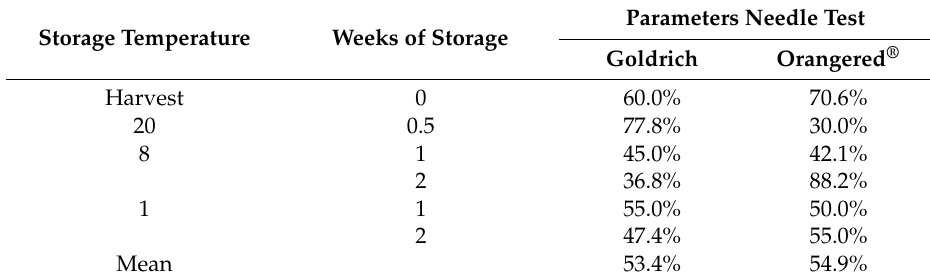
Table 4. Percentage of correctly classified ‘Goldrich’ and ‘Orangered ® ’ apricots according to storage temperature and duration obtained with DA performed on 10 parameters extracted from force/distance curves from puncture test.